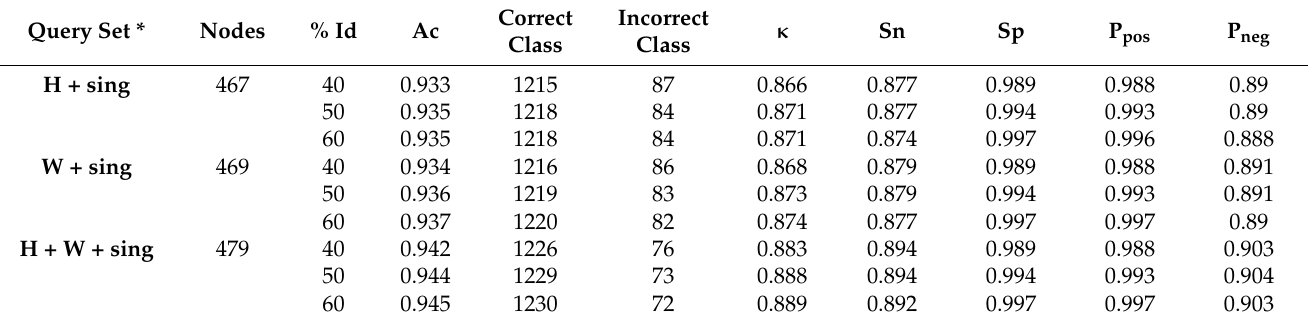
Table 2. Statistical analysis for the performance of the best 9 SSMs on the target Main dataset.